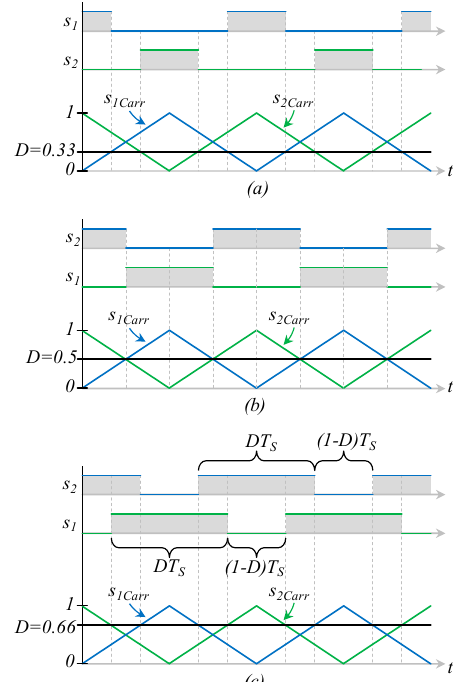
Figure 6. PWM and switching functions for different cases of the duty cycle: ( a ) when D = 0.33, ( b ) when D = 0.5, and ( c ) when D = 0.66; in this last case, time-period calculations are shown. Case D < 0.5: When the duty cycle is smaller than 0.5 , PWM signals are as shown in Figure 6a; the low value of D causes each switch to close for a short period of time, and the second transistor to close after a time in which both signals are off (a digital 0). There is not a time in which both transistors are closed at the same time (signals blue and gray are not high simultaneously in Figure 6a, and then the switching state in Figure 5c did not appear, all other three switching states in Figure 5 ( s 1 = 1 and s 2 = 0, s 1 = 0 and s 2 = 1, and s 1 = 0 and s 2 = 0) are present in this operation mode.